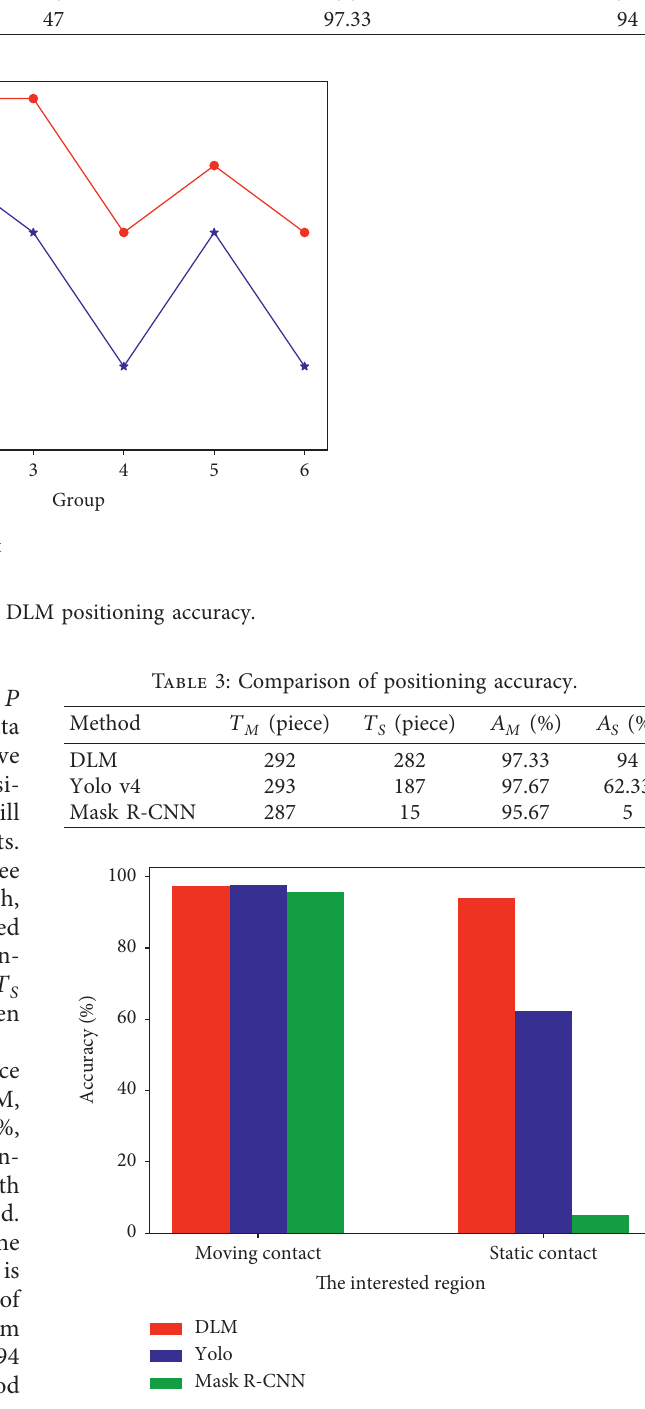
Figure 16: Comparison of positioning accuracy of moving and static contacts by DLM, Yolo, and Mask R-CNN